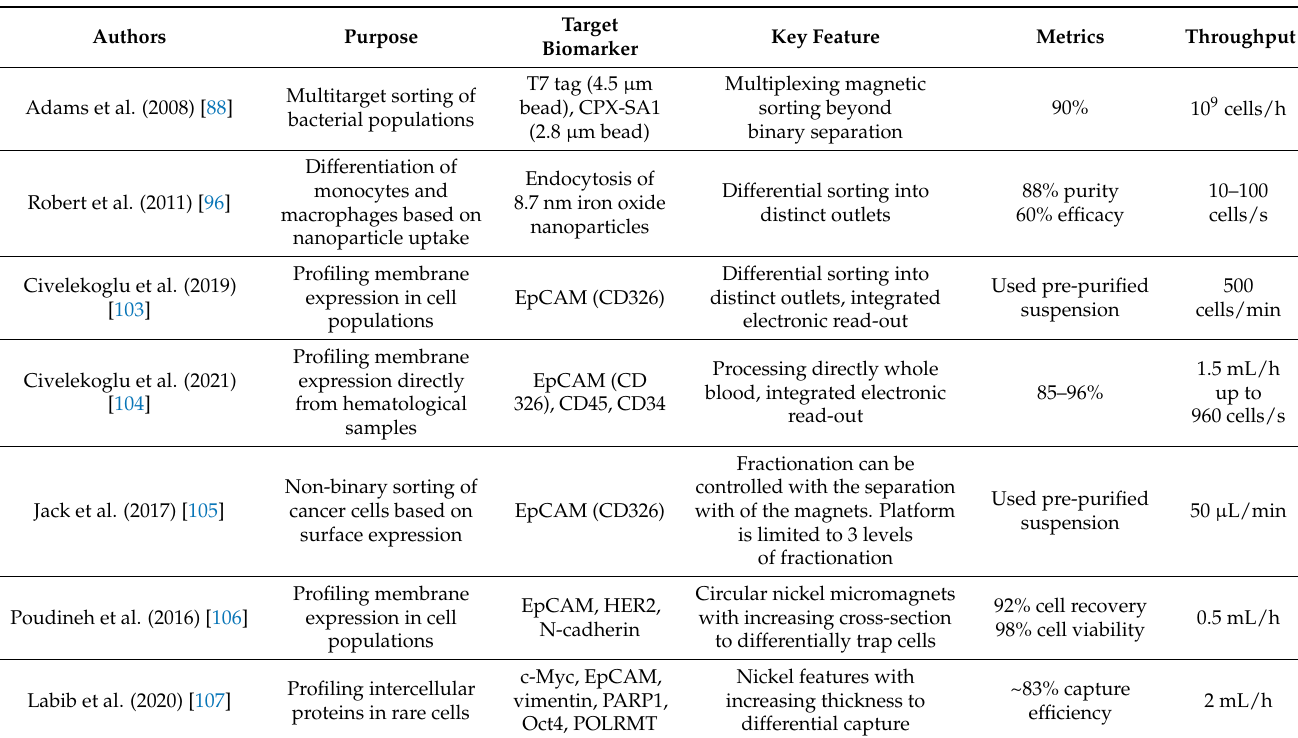
Table 3. Summary of the recent magnetophoretic platforms for non-binary